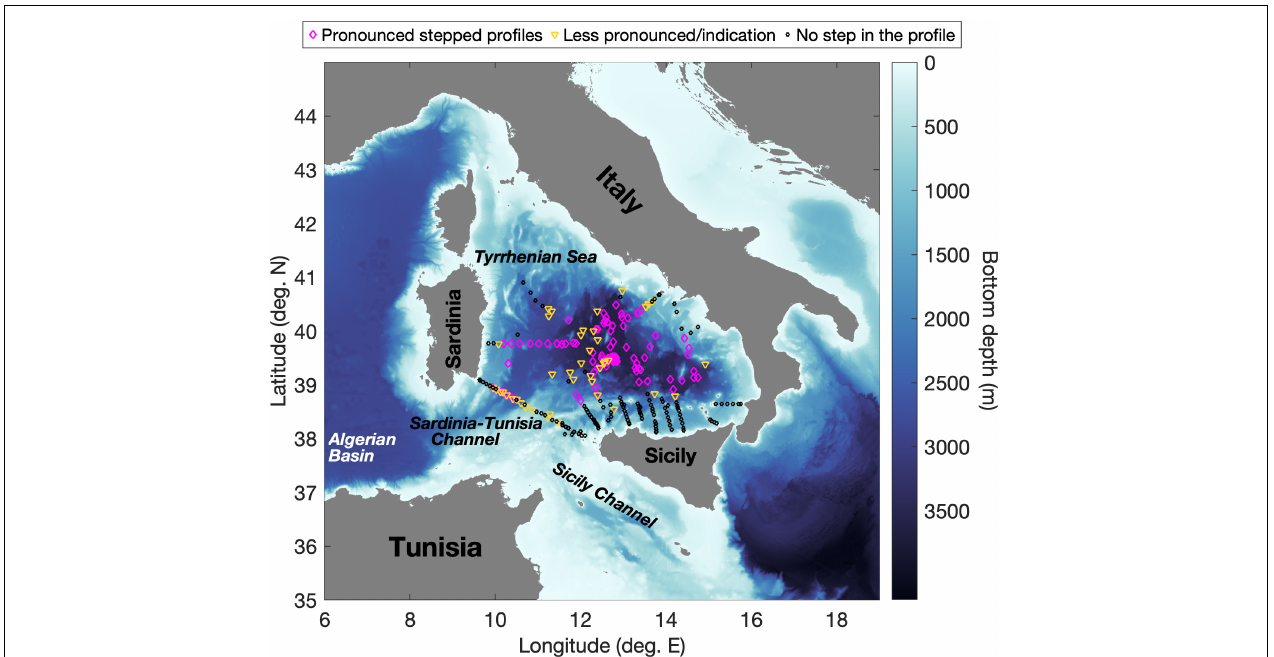
FIGURE 1 | The Tyrrhenian Sea (Western Mediterranean); symbols denote stations from Johannessen and Lee (1974), Molcard and Williams (1975), Zodiatis and Gasparini (1996), Sparnocchia et al. (1999), Falco et al. (2016), Durante et al. (2019), Sparnocchia and Borghini (2019), and Taillandier et al. (2020), indicating the locations where well-defined/less-defined stepped profiles or profiles with no indication of steps were reported. The bathymetry is that of the GEBCO Bathymetric Compilation Group (2019), and the colormap used is from Thyng et al.